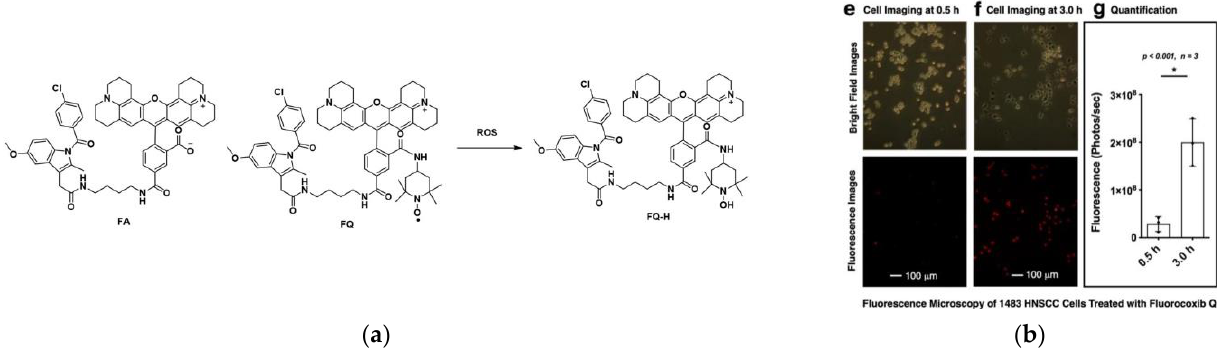
Figure 5. ( a ) Structure of FA, FQ, FQ-H; ( b ) Fluorescence images of 1483 HNSCC cells treated with FQ. Reproduced with permission from [42]. Copyright 2022 American Chemical Society.